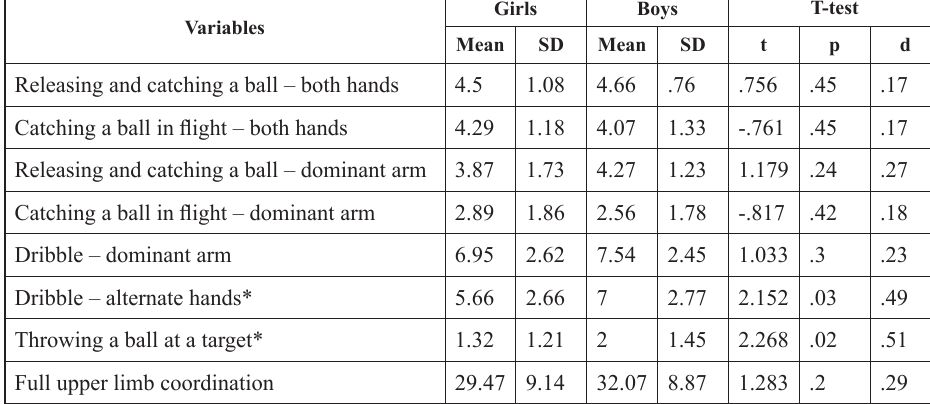
2. Differences between groups (De- scriptive statistics and Independent-Samples